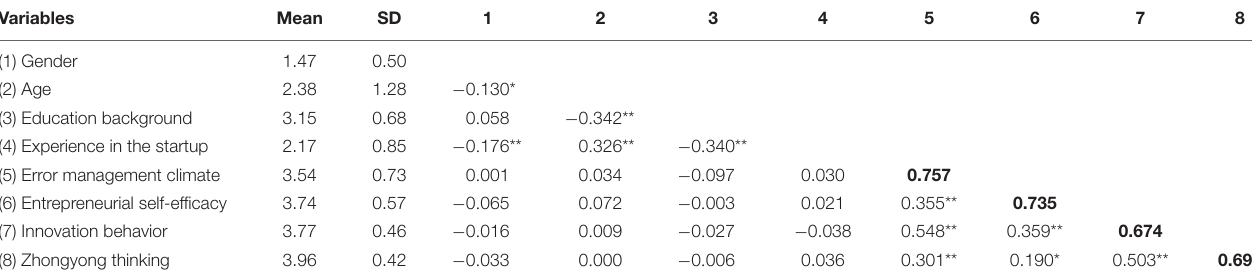
TABLE 3 | Descriptive statistics and correlations among the variables.